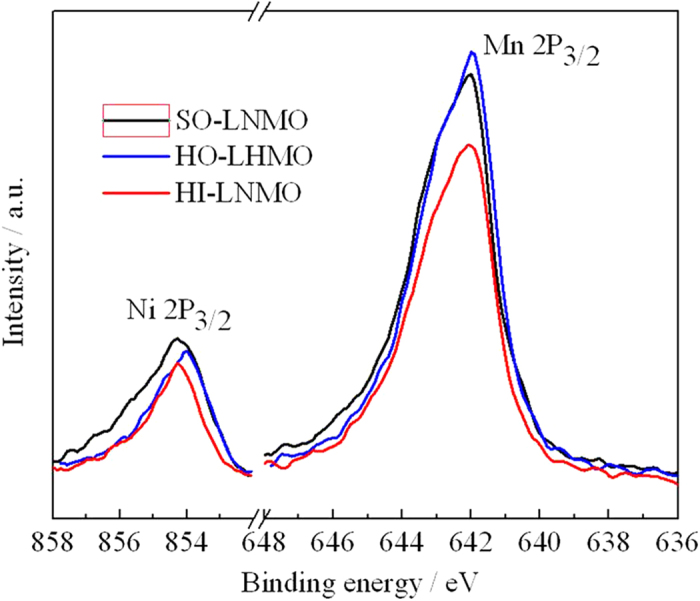
Ni 2p3/2 and Mn 2p3/2 XPS spectra of LiNi0.5Mn1.5O4 with different microstructures.